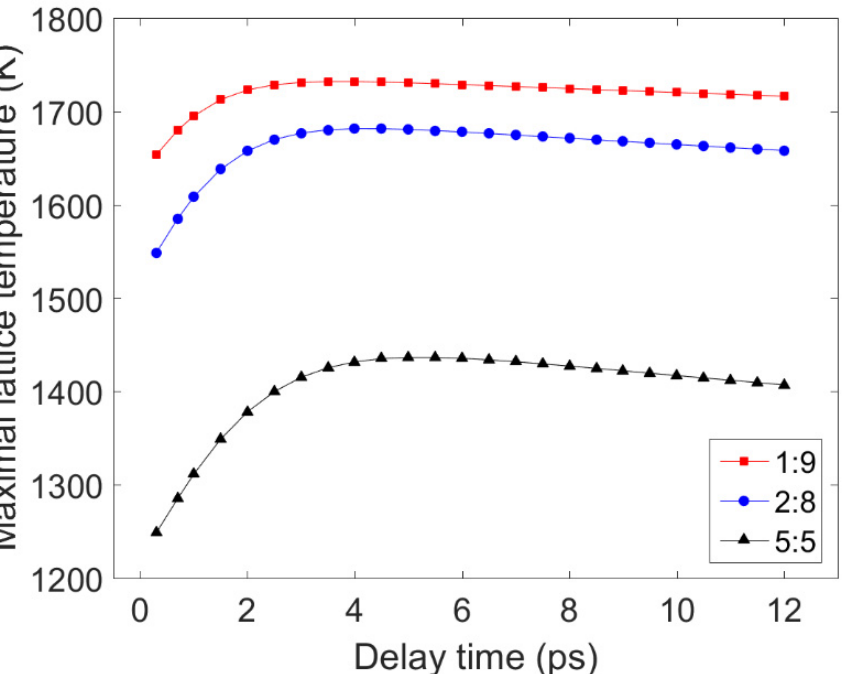
Figure 9. Changes in the maximum lattice temperatures with respect to the delay time for irradiation by double pulses with three energy ratios. The solid red, blue, and black lines represent the results obtained using double pulses with en- ergy ratios of 1:9, 2:8, and 5:5, respectively.